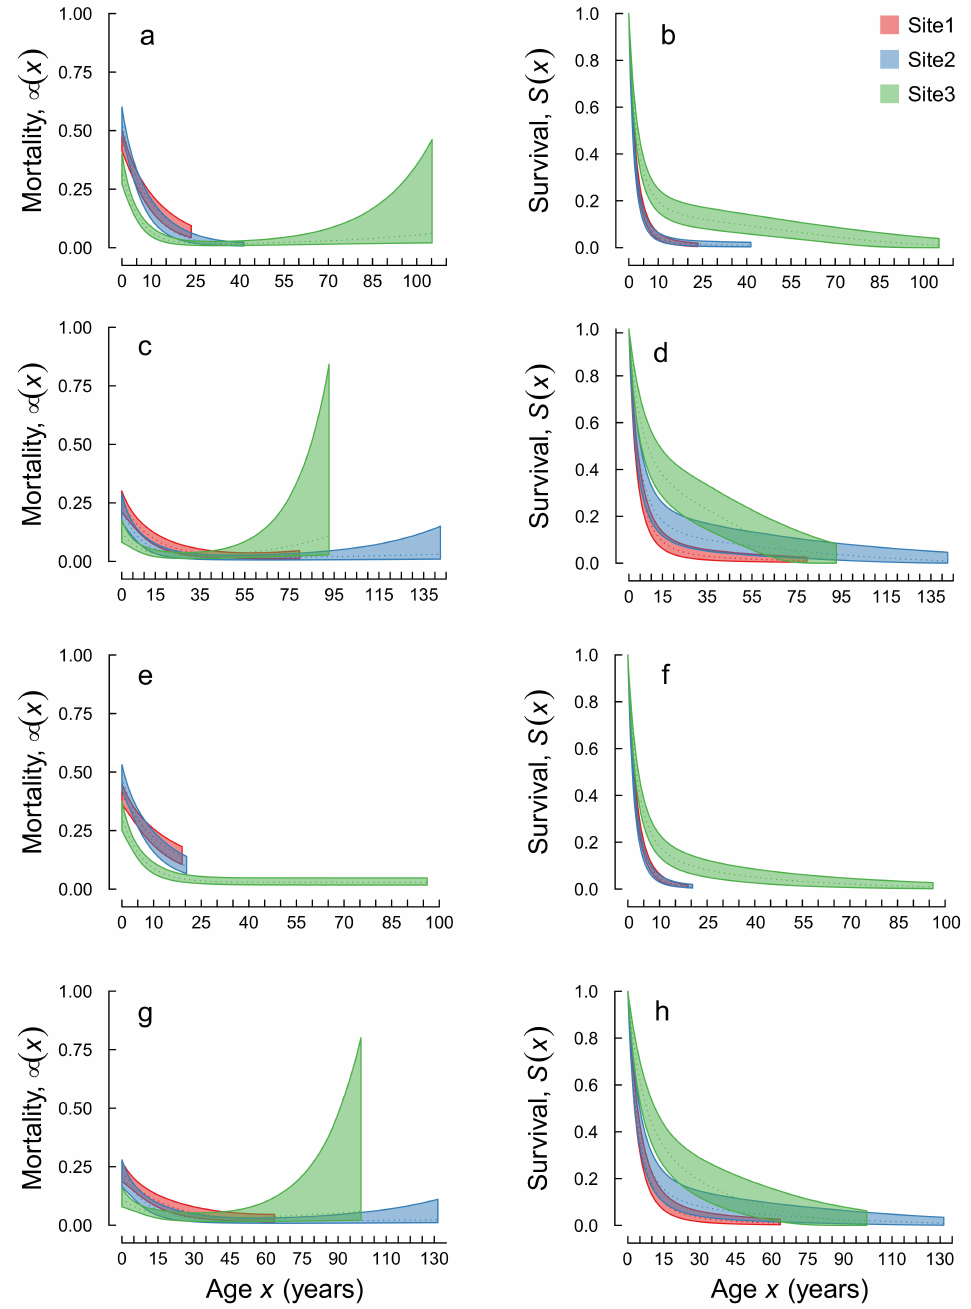
Figure A1. Mortality and survival trajectories of Pulsatilla vulgaris ssp. gotlandica from germination for the basic model with only sites ( a , b ), growth ( c , d ), reproductive output ( e , f ) and shrinkage ( g , h ). Lines end where the population reaches 1% of its original